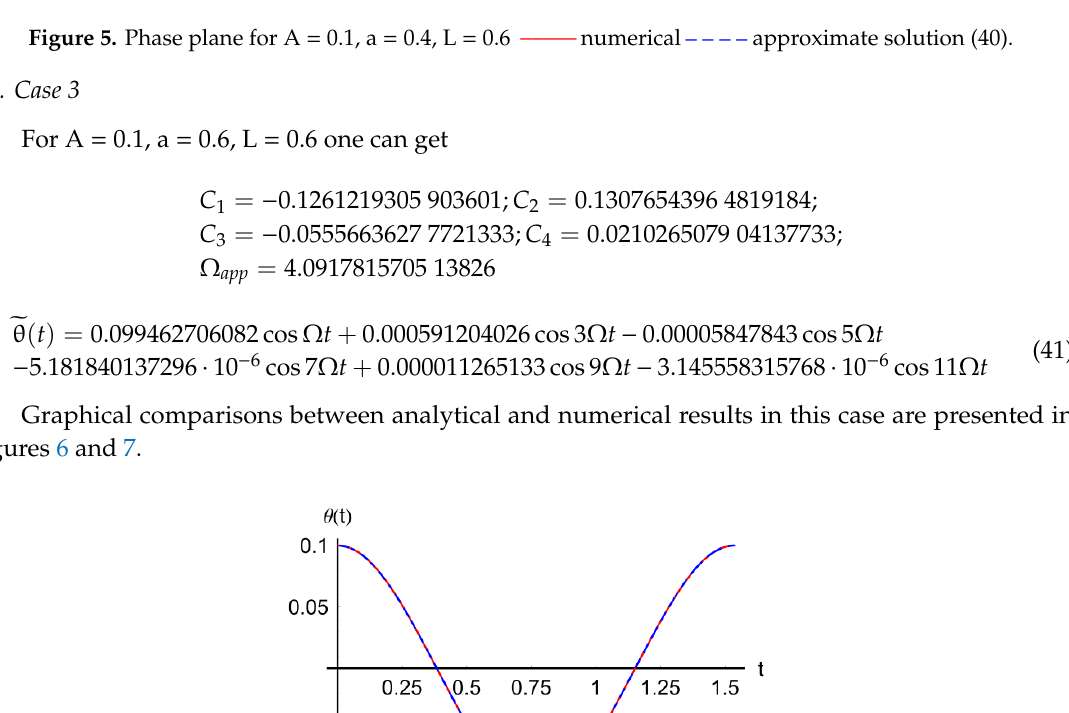
Figure 21. Phase plane for A = 0.4, L = 0.6.